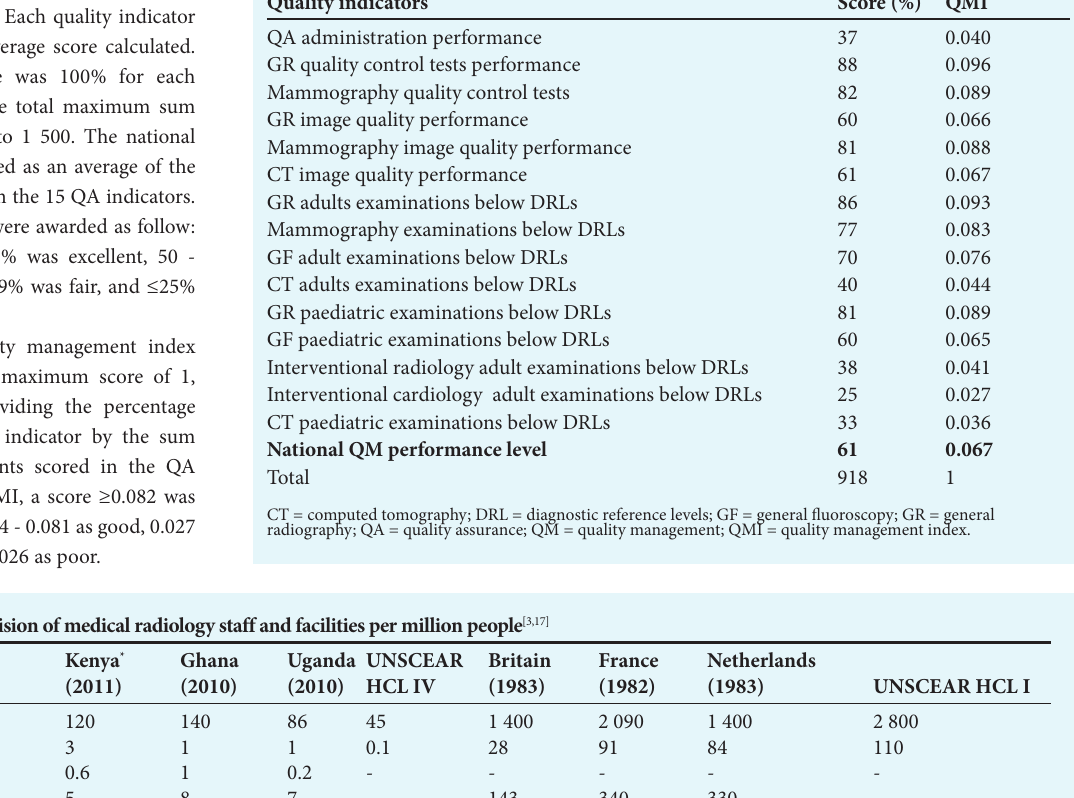
indicator, bringing the total maximum sum